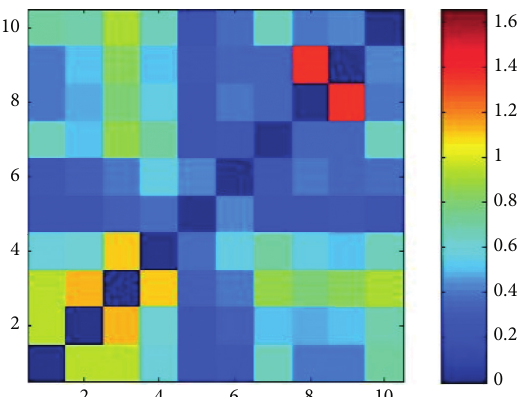
Figure 1: Colormap of industry sector indexes network in the calm period (the numbers on the horizontal and vertical axes represent the 10 sector indexes in Table 1).